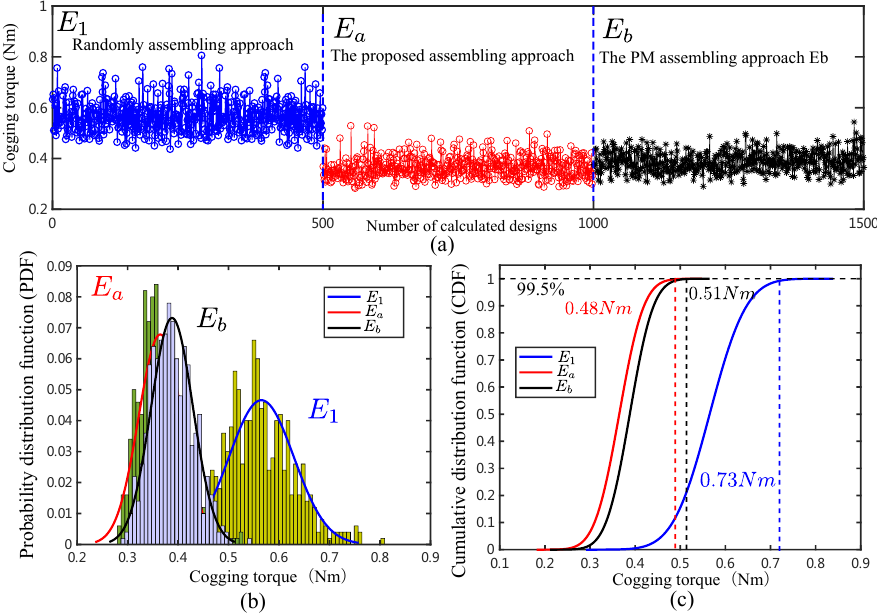
Figure 15. Cogging torque performance of the three assembling approaches. ( a ) The peak-to-peak cogging torque, ( b ) the probability distribution function, ( c ) the cumulative distribution